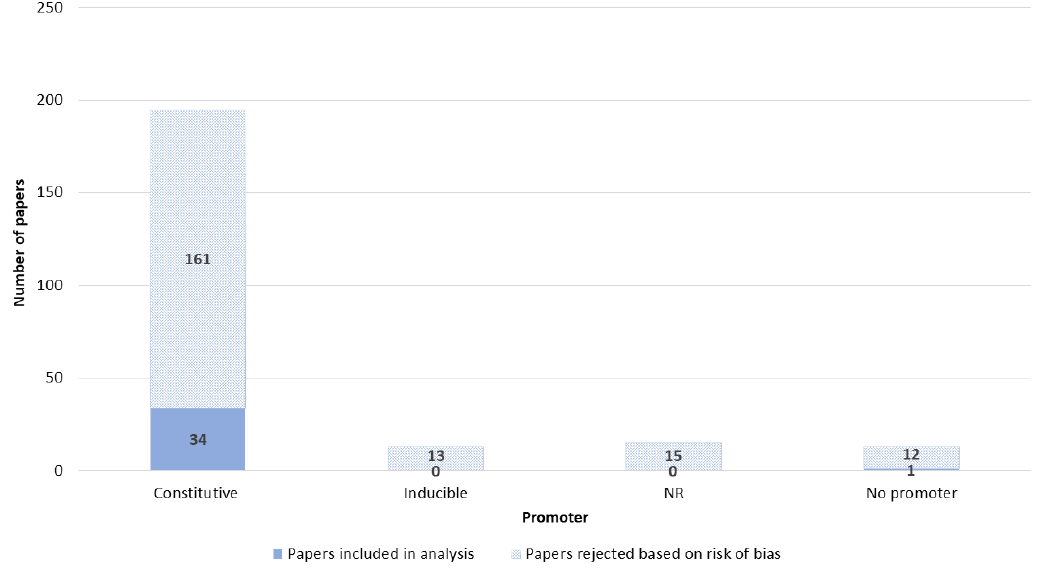
Figure 9. Promoter of NA. NR—not reported.